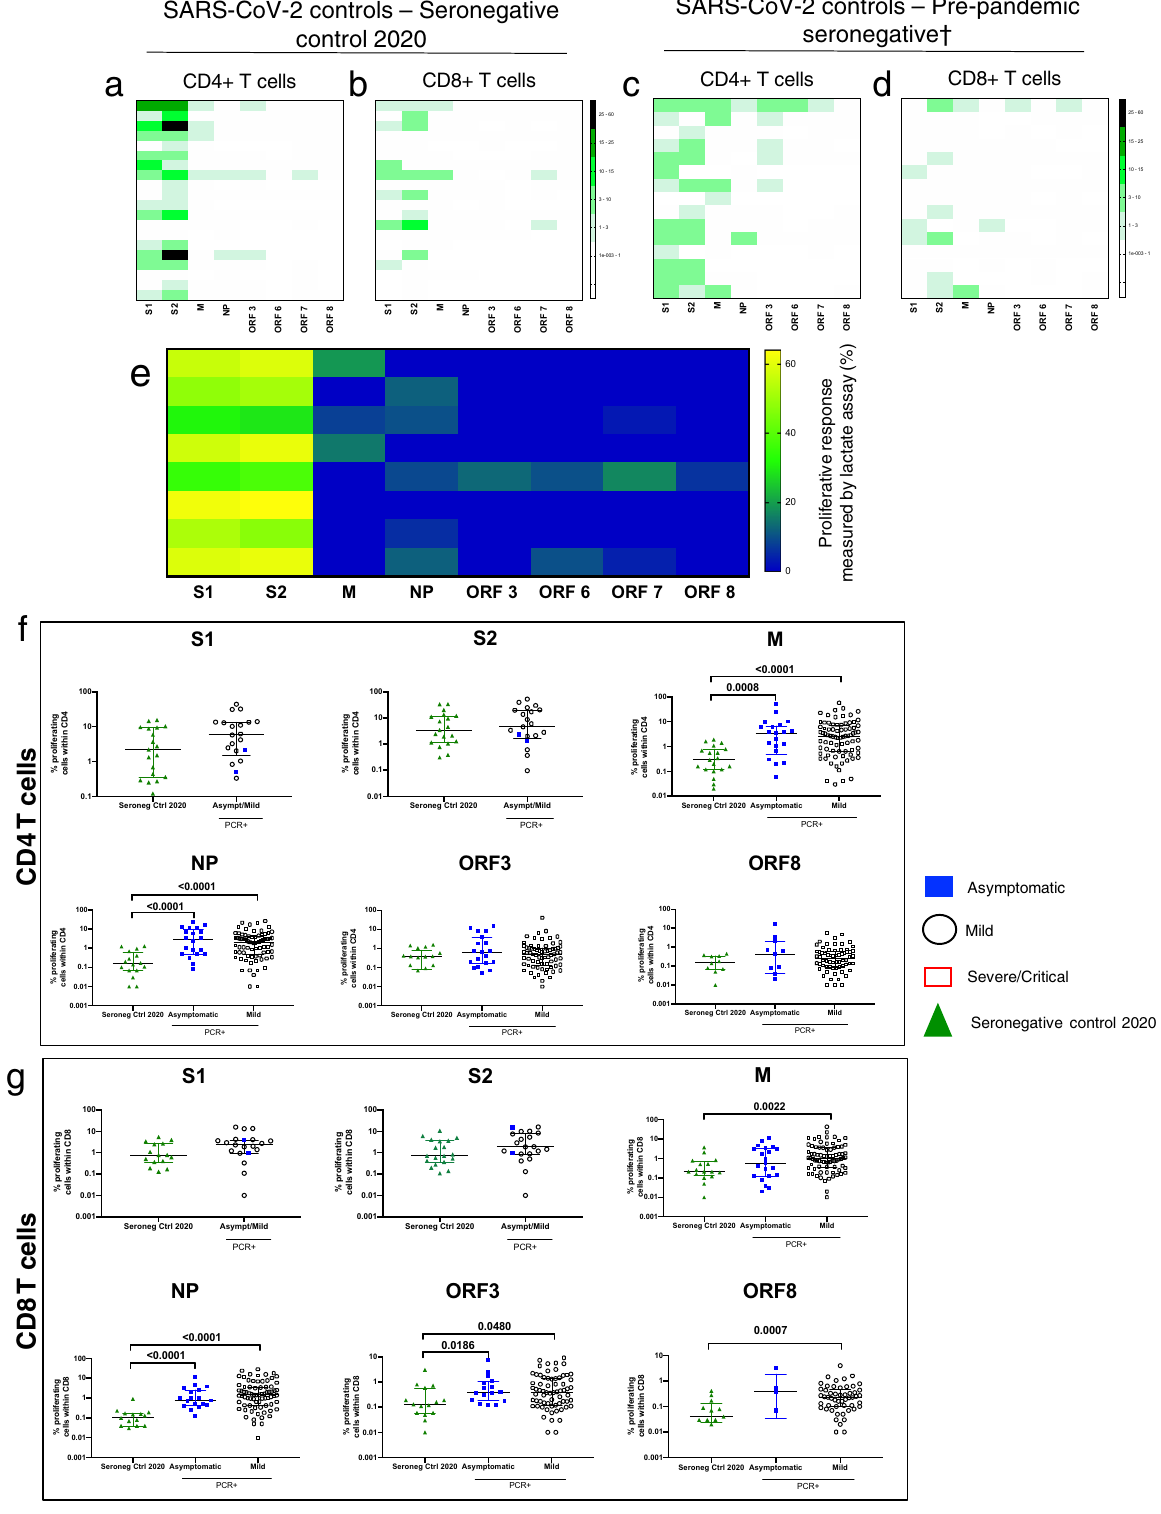
The robust T cell memory responses in the control groups high exposure to four circulating HCoVs, as also seen in other to spike protein are clear in our data, and consistent with a studies 9 – 11,18 – 21 (Supplementary Fig. 7). We next addressed the homology between S and HCoVs at the level of 9-mer recent study that assessed cross-reactivity using a different peptides and compared this to M and NP (Supplementary assay system 21 addressing the issue of whether this re fl ects prior exposure to HCoVs. To explore this further, we fi rst Fig. 8a) The median alignment score for each spike, NP and M tested our cohort using serologic assays and found universally proteins was 8.5, 7.5 and 6.5, respectively, which indicates that NATURE COMMUNICATIONS| (2021) 12:2055